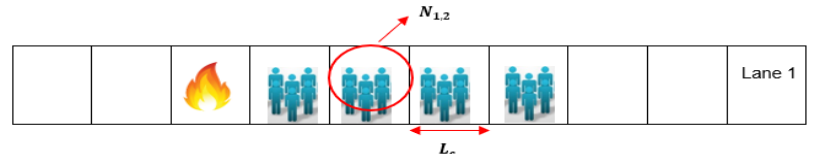
Figure 2. Distribution of users in cells adopted from